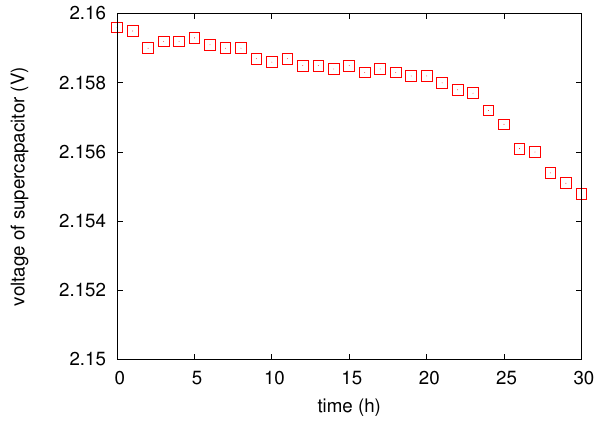
The voltage variation after disconnecting the energy source from the